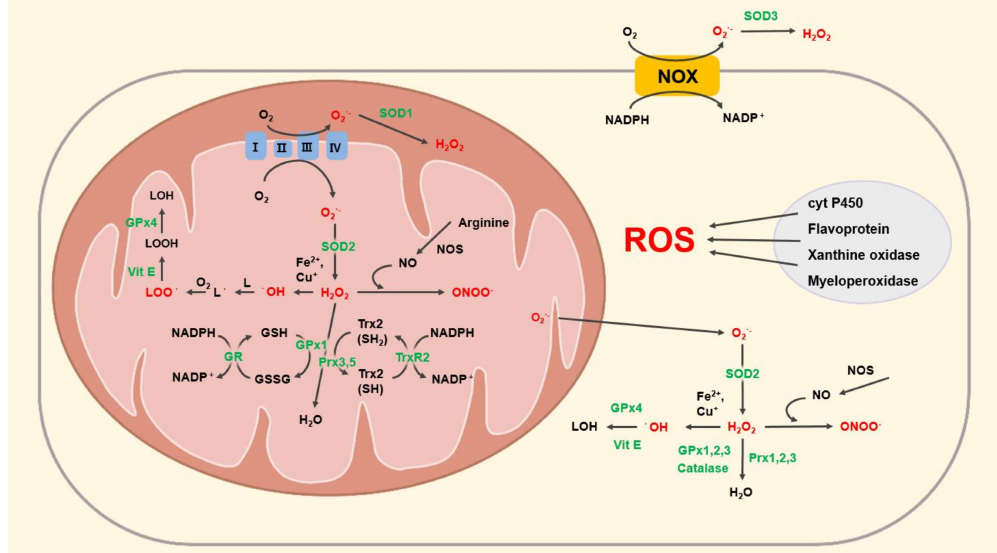
Figure 1. A schematic illustration showing the generation of ROS in mitochondria and other cellular regions. The red-colored letters refer to ROS, while the green-colored letters refer to enzymes that are associated with the reduction of ROS. Briefly, in mitochondria, the electron transport chain (ETC) produces and releases O 2 · − into the intermembrane space and the matrix. O 2 · − is then converted to H 2 O 2 by superoxide dismutase (SOD). H 2 O 2 is converted to water by the glutathione peroxidase (GPx) or peroxiredoxin (Prx) pathways. The Fenton reaction between Fe 2 + and H 2 O 2 yields · OH, which initiates lipid peroxidation. Through vitamin E (Vit E) and GPx4, LOO · is converted to LOH. NOS synthesizes NO from arginine. NO then can react with H 2 O 2 to produce ONOO − . This same process also occurs in the cytoplasm. ROS can also be produced by other enzymes such as NOX, cytochrome P450 (cyt P450), Flavoprotein, Xanthine oxidase, and Myeloperoxidase. Roman numerals (I, II, III, and IV) refer to mitochondrial ETC